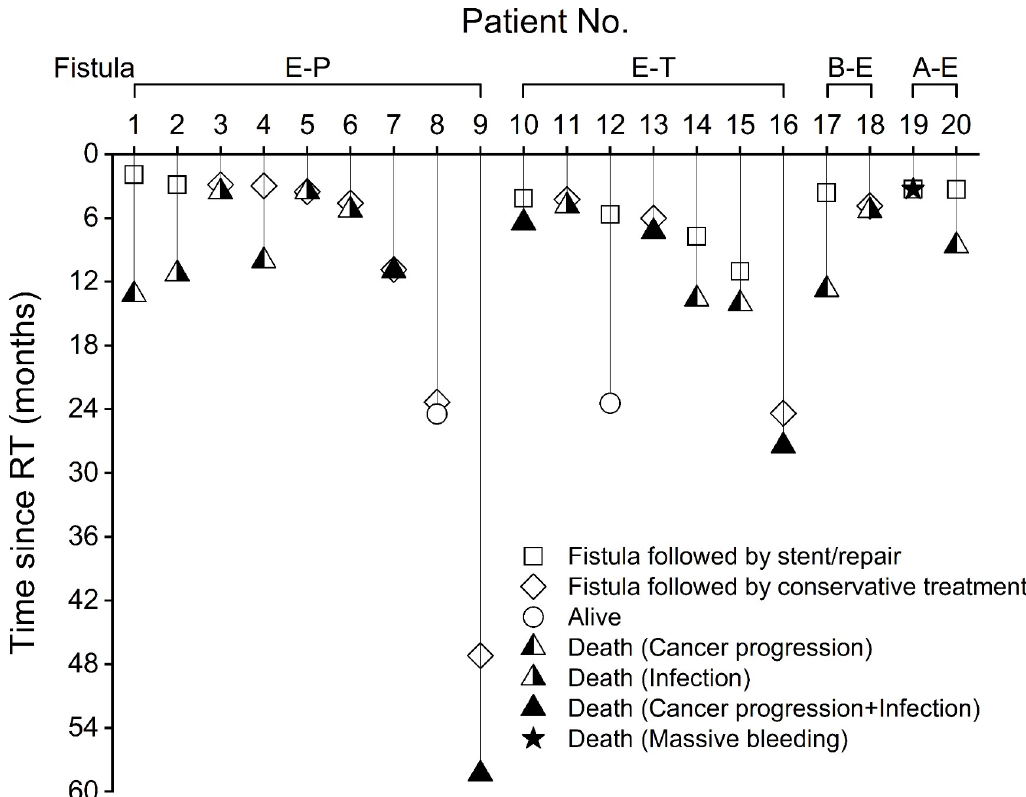
Fig 3. Clinical course of esophageal fistula in 20 cases. A-E, aorto-esophageal. B-E, bronchio-esophageal. E-P, esophago- pleural. E-T, esophago-tracheal.